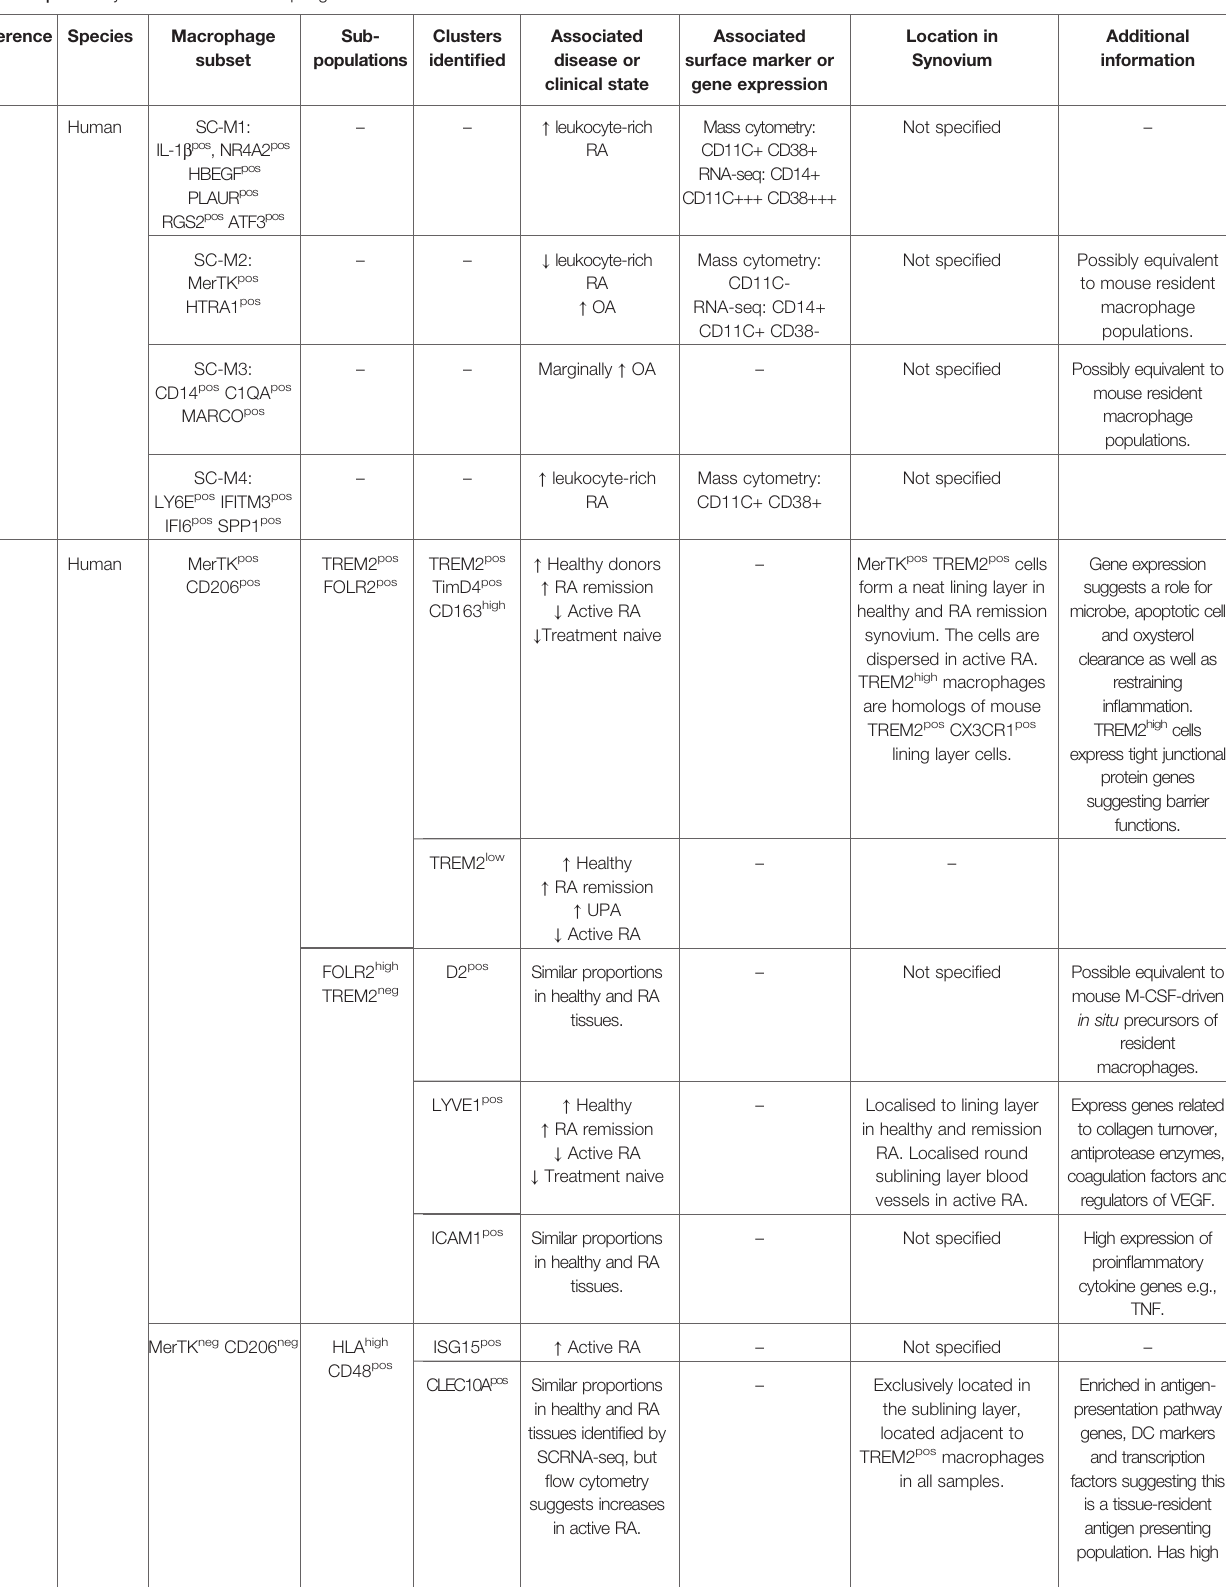
TABLE 1 | Recently Identi fi ed novel macrophage